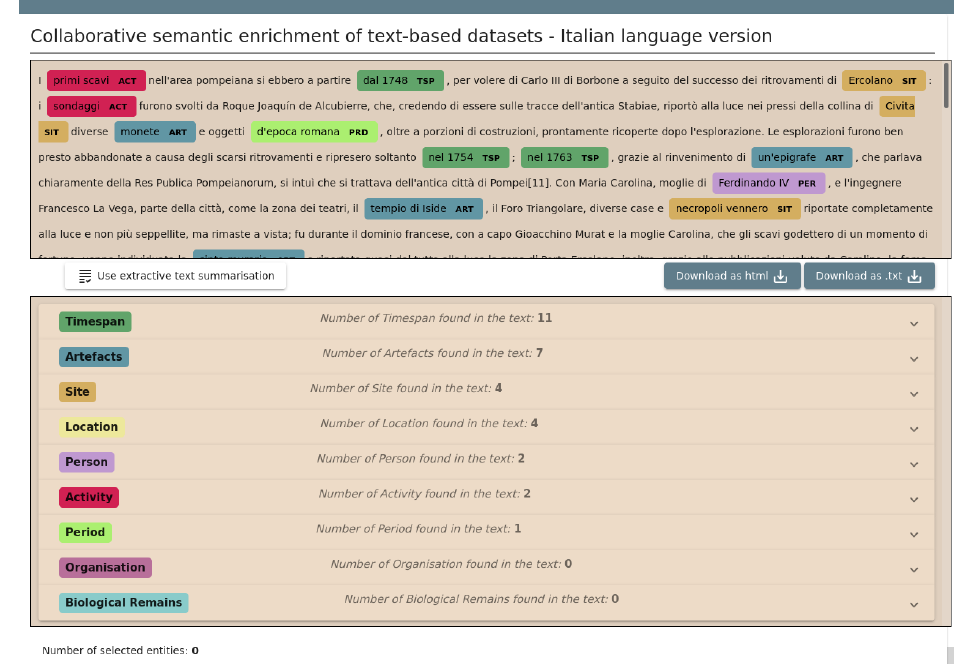
Figure 6. The NER web page after the ArcheoNER analysis. It can be seen the labels ordered by the number of entities found. On the left, under the annotated text, it is possible to see the button to show the summarised